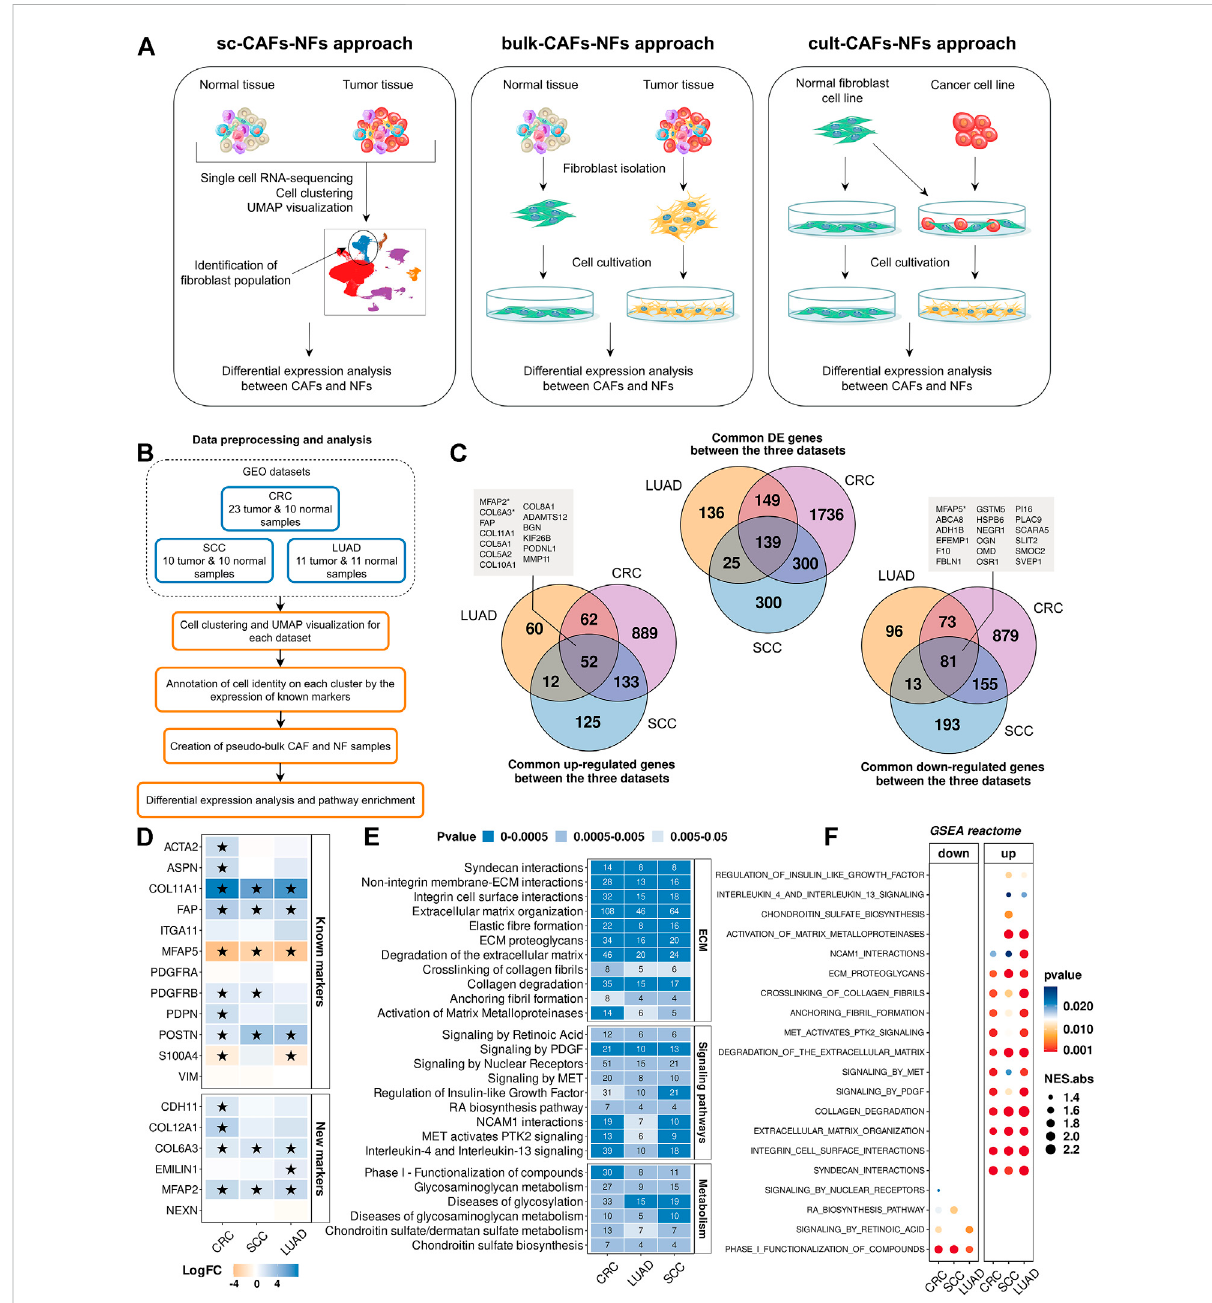
FIGURE 2 Comparison of gene expression between CAFs and NFs within the sc-CAFs-NFs approach. (A) Schematic diagram showing the work fl ow for eachofthethreeapproachestocomparingCAFsandNFs. (B) Work fl owforcomparinggeneexpressionbetweenCAFsandNFsbyanalyzingscRNA- seq data from tumors and normal tissues. (C) Venn diagram representing the intersection of genes differentially expressed between CAFs and NFs (upper diagram), up-regulated in CAFs (lower left diagram) and down-regulated in CAFs (lower right diagram) for colorectal cancer (purple circle), lung adenocarcinoma (yellow circle) and squamouscell carcinoma (blue circle). The boxes indicate the namesof the genes that are included in the list of 414 CAF markers proposed by us. (D) Heatmaps showing differences in the gene expression level in CAFs relative to NFs. At the top is a heat map for common CAF marker genes, and at the bottom for our proposed CAF marker genes. Asterisks indicate signi fi cant differences in the expression ( | logFC | ≥ 1 and FDR < 0.05). Blue = increased gene expression in CAFs compared to NFs, orange = decreased gene expression in CAFs compared to NFs. (E) Heat map of the Reactome Pathway enrichment analysis. It represents the genes differentially expressed between CAFs and NFs. The x-axis shows the types of tumor; the y-axis shows the signaling pathways. The numbers in the boxes are the number of genes associated with the certain pathway for the given type of tumor, with a p -value < 0.05. (F) Dot plots of GSEA results illustrating the enrichment of the common Reactome pathway gene sets identi fi ed by the enrichment analysis in the sc-CAFs-NFs approach. Types of tumor: CRC- colorectal